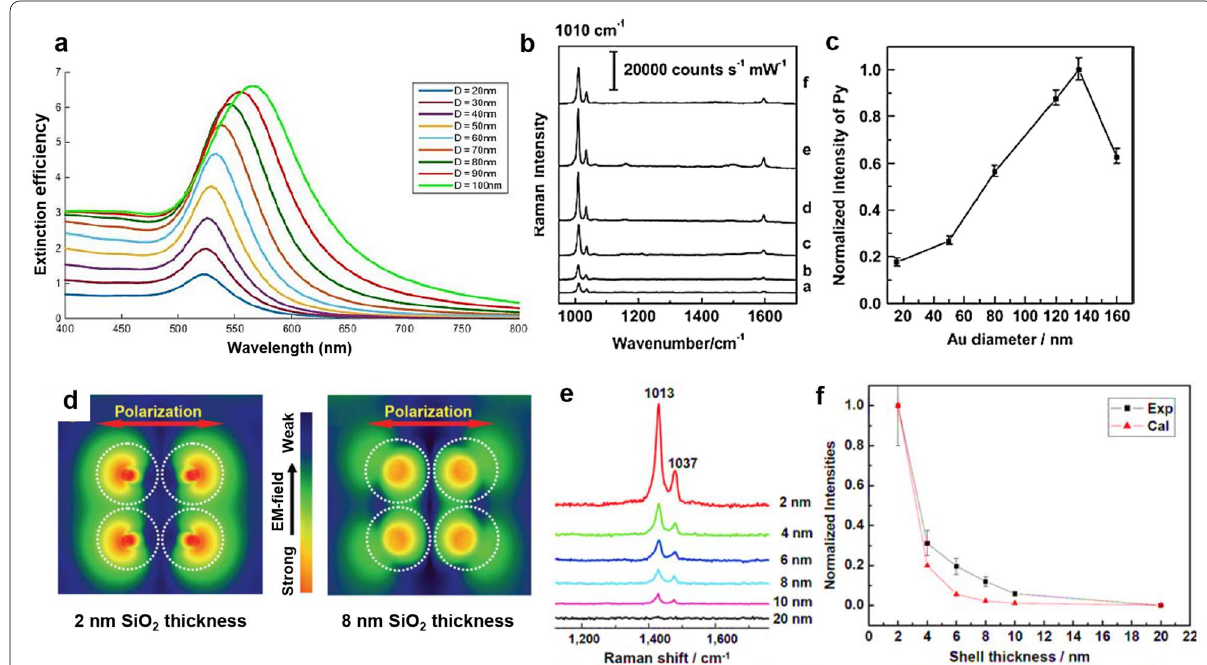
Fig. 4 a The extinction efficiency of Au nanospheres with different diameters, reproduced with permission from [32]. Copyright (2018) IOP Publishing Ltd. b ) SERS spectra of pyridine adsorbed on Au nanoparticles with different sizes: 16 to 160 nm (from a – f ). c The normalized SERS intensity of pyridine as a function of the Au nanoparticle size, reproduced with permission from [33]. Copyright (2008) John Wiley and Sons, Ltd. d The top view of 3D-FDTD simulation from a 2 2 array of 55 nm Au@SiO 2 nanoparticles showing the distribution of electromagnetic field × enhancement as a function of shell thickness (the color gradient represents the strength of the electromagnetic field, and the white dash circles indicate the Au@SiO 2 nanoparticles. e SHINERS spectra of pyridine adsorbed on a smooth Au surface coated with Au@SiO 2 with different silica shell thicknesses. f The dependence of the normalized intensity of pyridine on the shell thickness, reproduced with permission from [21]. Copyright (2010) Macmillan Publishers